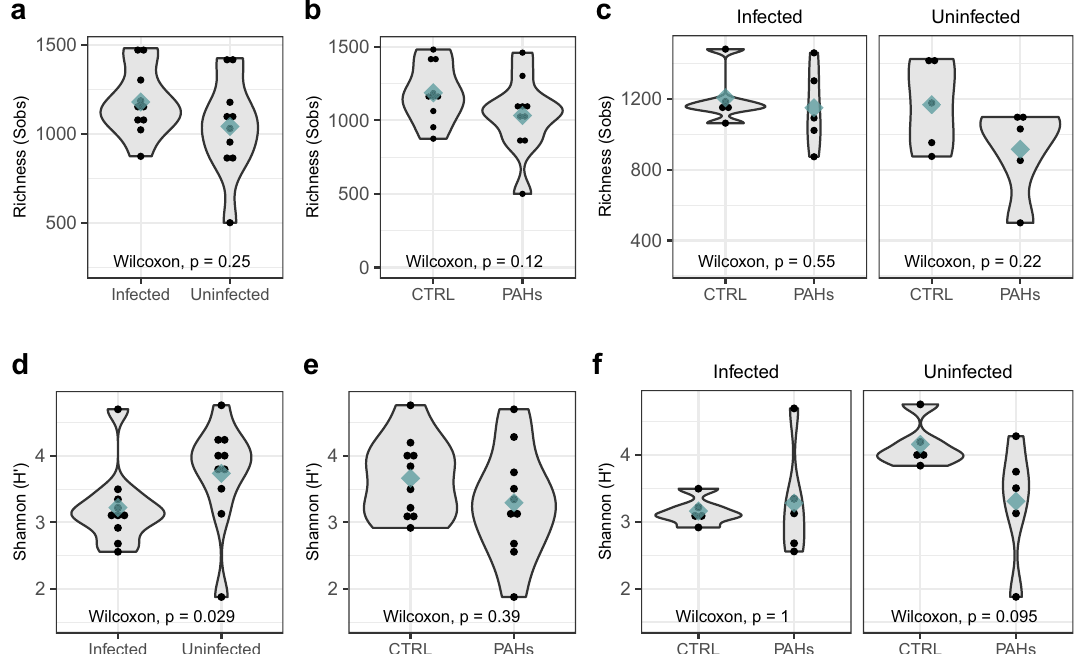
Figure 1. Gut bacterial richness and diversity. Observed richness (S obs , panels a – c ) and Shannon–Weaver (H ′ , panels d – f ) indexes were estimated for fish gut bacterial communities. Alpha-diversity indexes were compared between infected and uninfected chub (n = 20 samples; panels a and d ) and between controls and PAH-exposed chub (n = 20; panels b and e ). In parallel, PAH effect was analyzed independently on uninfected (n = 10) and infected chub (n = 10) (panels c and f ). The median is shown as a green diamond. Mann Whitney Wilcoxon tests were used to investigate differences between groups and the p values are shown on the plots.